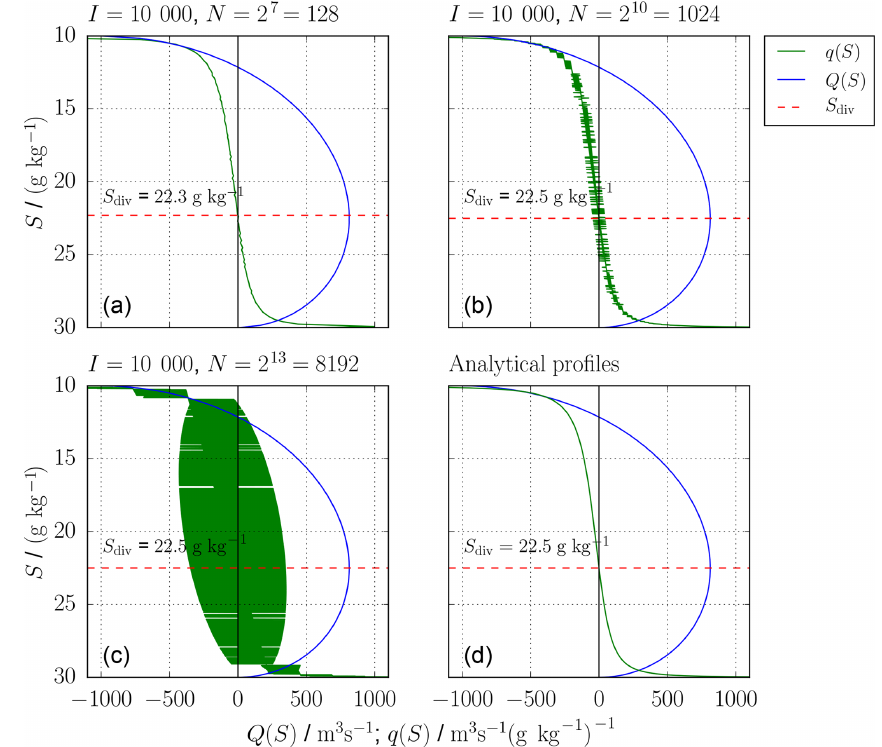
Figure 2. Oscillating exchange flow (see Sect. 2): from (14) and (15) numerically (a–c) and analytically (d) found Q(S) (blue), q(S) (green), dividing salinity, S div (dashed, red), for I = 10 4 time steps for one tidal cycle and varying number of salinity classes N . With increasing N , q becomes more noisy, whereas Q seems unchanged.